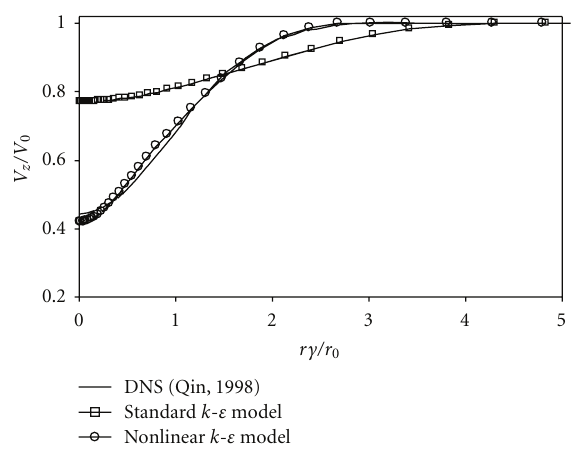
Figure 6: k - ε model prediction of axial velocity profile compared with Qin’s DNS results ( t = 3.72 T ).